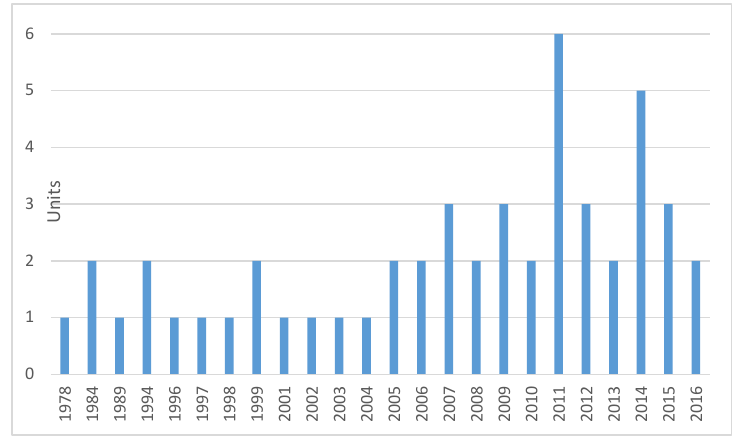
Figure 1. Number of publications by year.